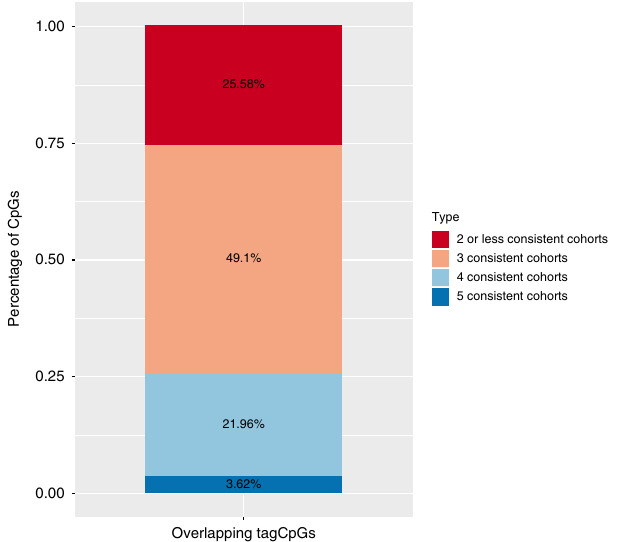
Fig. 6 Consistency of best models across cohorts. Percentage of consistent best models in overlapping tag CpGs of PREDO I (450 K), DCHS I (450 K), PREDO II (EPIC), UCI (EPIC) and DCHS II (EPIC). Overlapping VMRs included signi fi cantly more CpGs as compared to all VMRs ( p < 2.2 × 10 − 16 , Wilcoxon-test, mean =